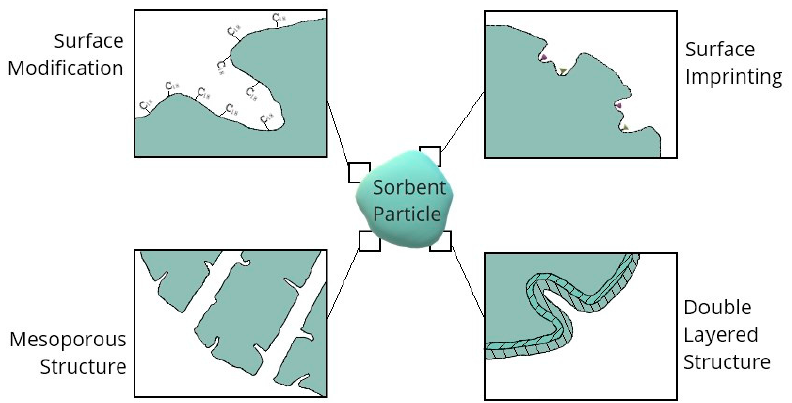
Figure 1. Examples of basic functional structures of SPE sorbents .